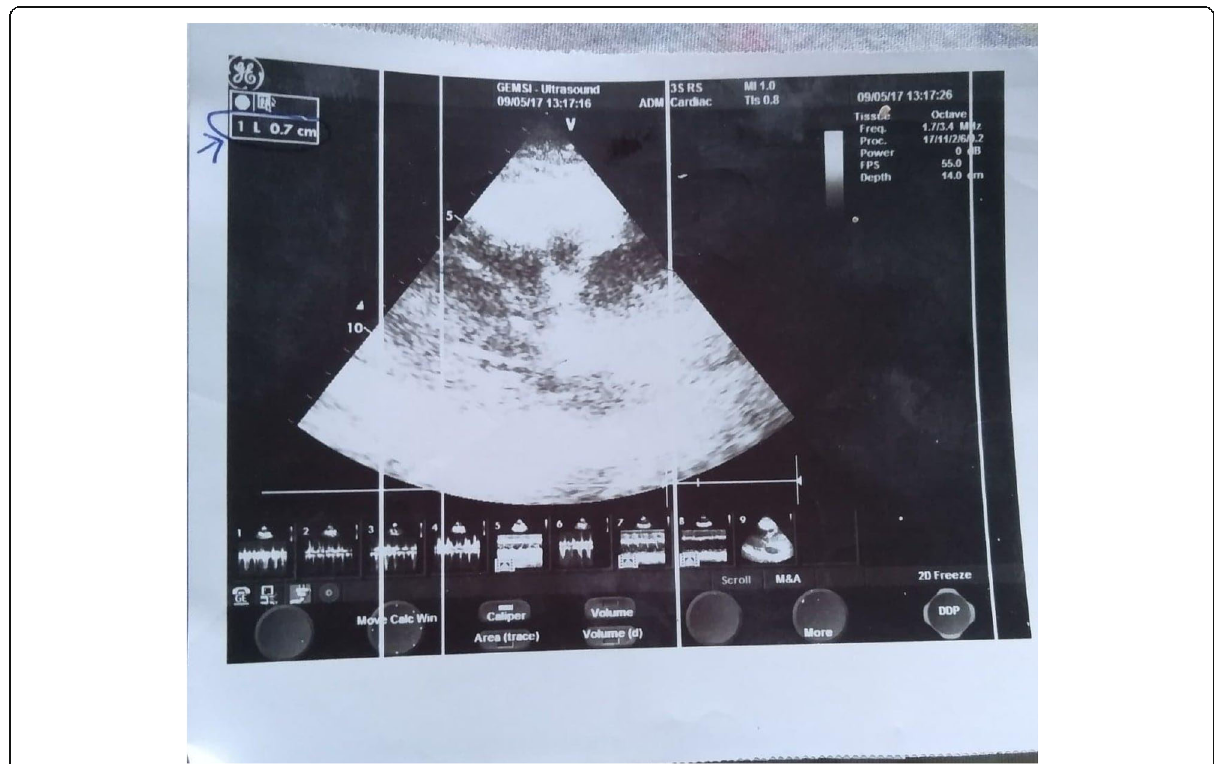
Fig. 2 Echocrdiographic epicardial fat thickness in male patient, 60 years old, hypertensive, diabetic with body mass index of 25, presented with right sided hemiplegia, and motor aphasia. Brain computed tomography showed left fronto-parietal cortical infarction. As shown, EFT was 7